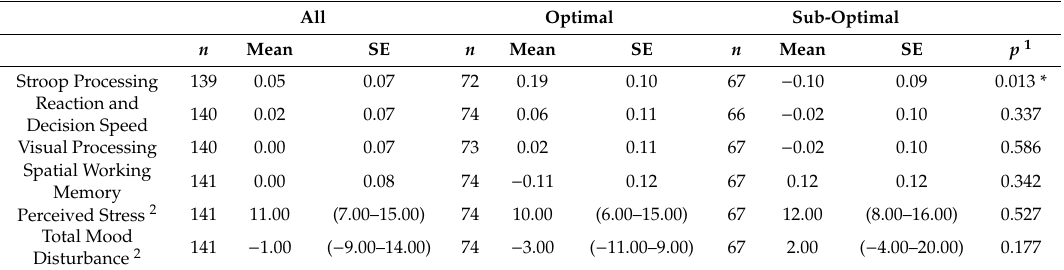
Table 4. Cognitive and mood outcomes for all participants and by diet quality